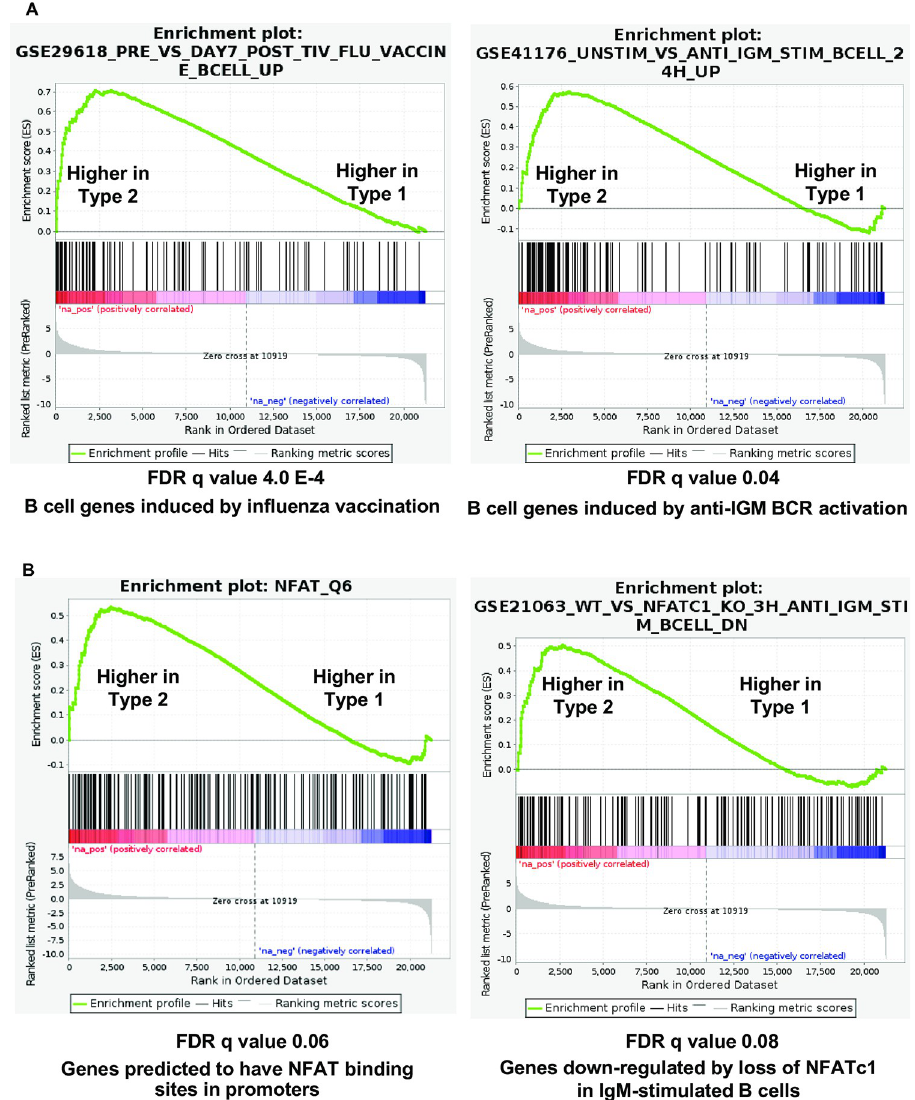
Fig 4. Gene set enrichment analysis (GSEA) suggests increased BCR and NFAT signaling in Type 2 LCLs. (A) GSEA plots for the “Pre versus day 7 post TIV flu vaccine B cell up”, and “unstimulated versus anti-IGM stimulated B cells 24 hours up” ( B ). GSEA plots for “NFAT_Q6” and “WT versus NFATC1 KO 3 hour anti-IGM stimulation B cell